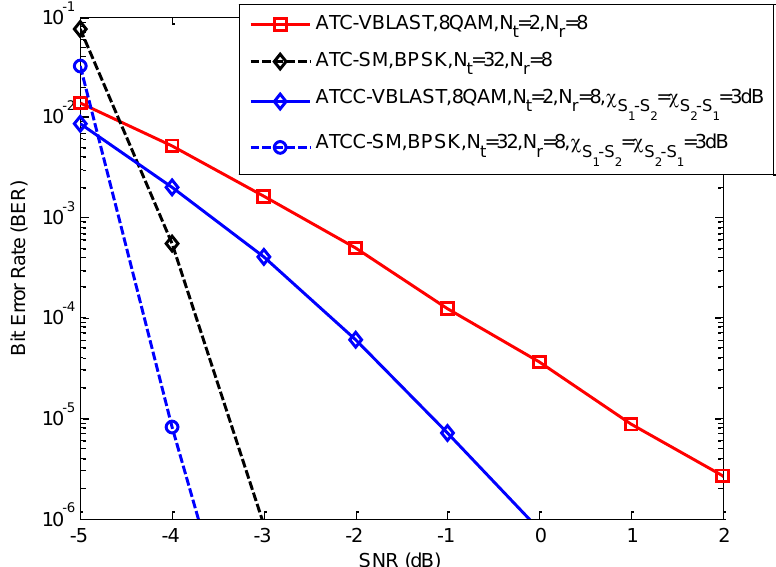
Figure 15. BER performance comparison of ATC-SM over BPSK, two-source ATCC-SM over BPSK under a non-ideal inter-user channel scenario, ATC-VBLAST over 8QAM, and two-source ATCC-VBLAST over 8QAM under a non-ideal inter-user channel scenario over the slow Rayleigh fading channel for the case of 6b / s / Hz transmission, K = 2048 and N r = 8 .